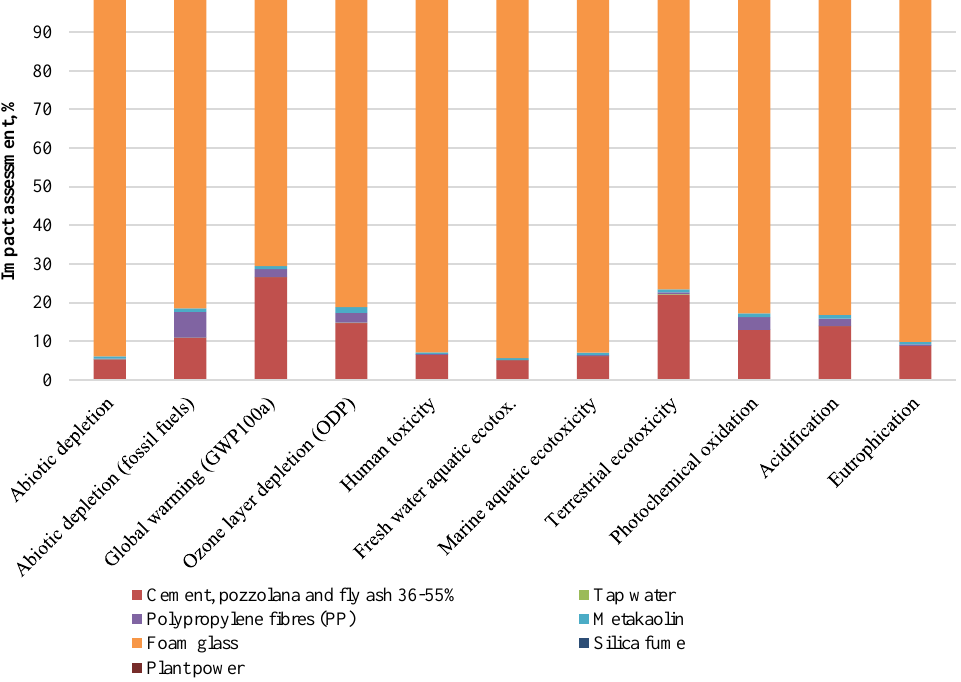
Fig. 5. Foam concrete FC-2.4 impact assessment by CML-IA baseline V3.04 /